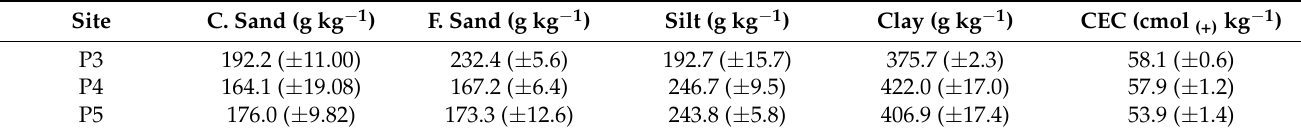
Table 3. Average values ( ± standard error) of particle size fractions (coarse (C) sand, fine (F) sand, Silt, and Clay) and Cation Exchange Capacity (CEC) in each site (P3 ( n = 9), P4 ( n = 9), P5 ( n = 12)), in the 20–40 cm